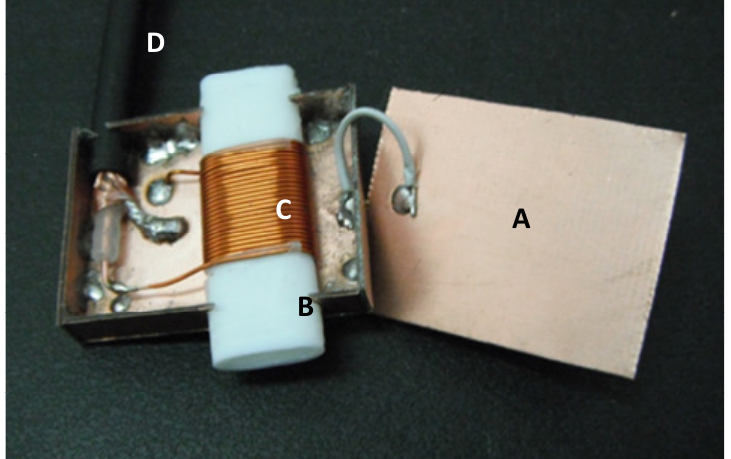
Figure 3. Faraday cage ( A ) containing Teflon tube ( B ), ellipsoidal RF coil ( C ), and RG58 coaxial cable ( D